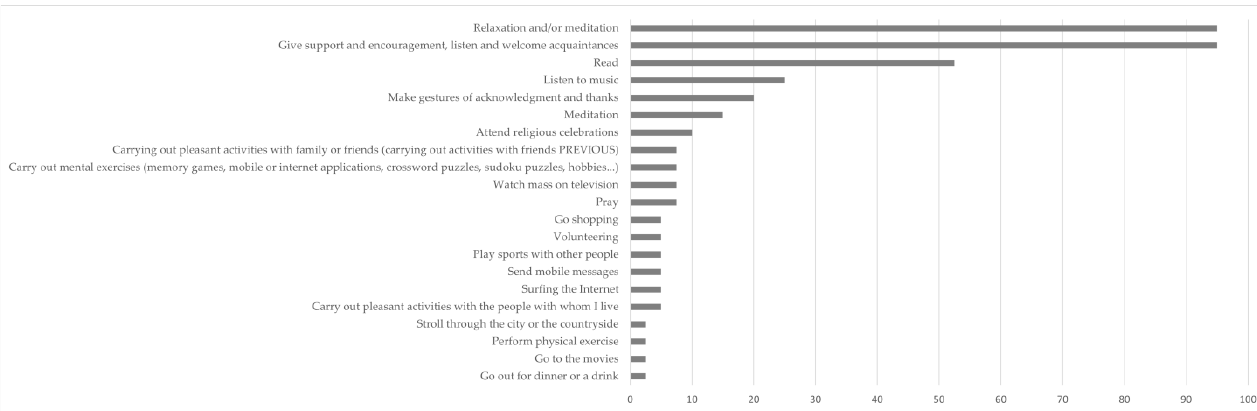
Figure 3. Percentage of people who carried out the activity before the pandemic and continue to do so.